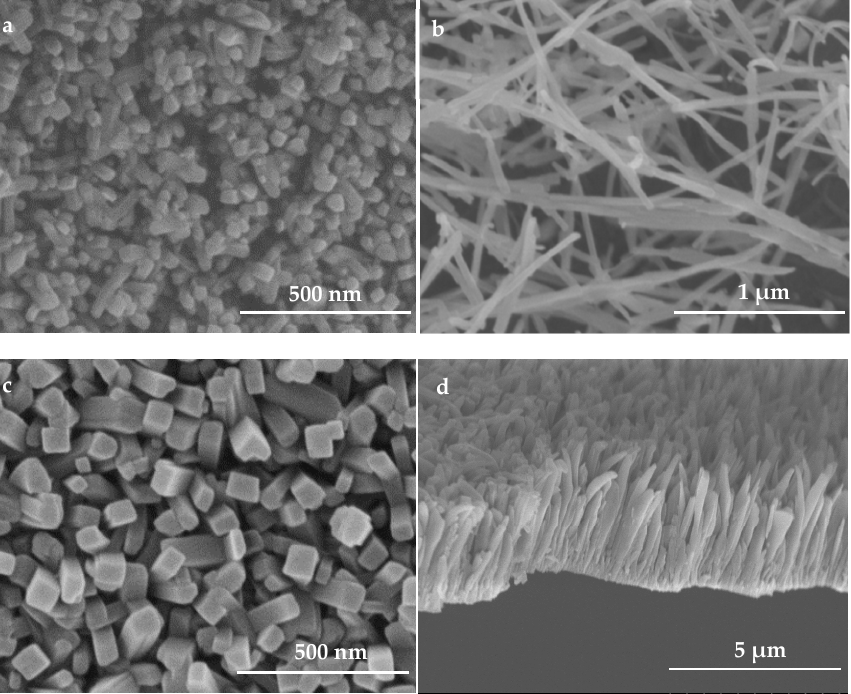
Figure 2. SEM images of synthesized catalysts with different morphologies: ( a ) nanogranules; ( b ) nanofibers; the top ( c ) and side ( d ) views of the nanorods.